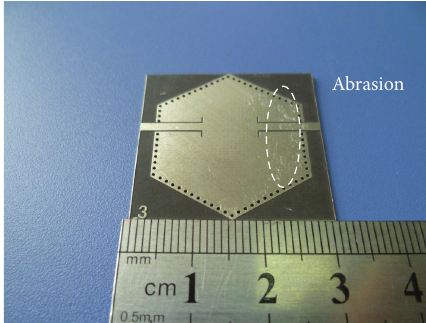
Figure 7: Photograph of the fabricated filter.